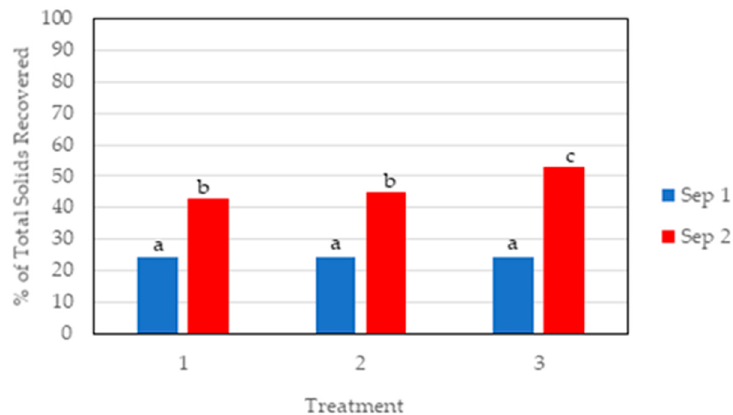
Figure 3. Recovered manure solids using a two-stage solid-liquid separation screen with acid addition. Data are expressed on a dry basis as percentage of initial total solids content of untreated dairy manure slurry. Treatments: (1) no acidification (control), (2) acid added before Sep 1 (12.7 mm screen), and (3) acid added before Sep 2 (0.25 mm screen). Bars represent the mean of duplicate tests. Means with the same letter (a, b, or c) are not significantly different according to LSD 0.05 .